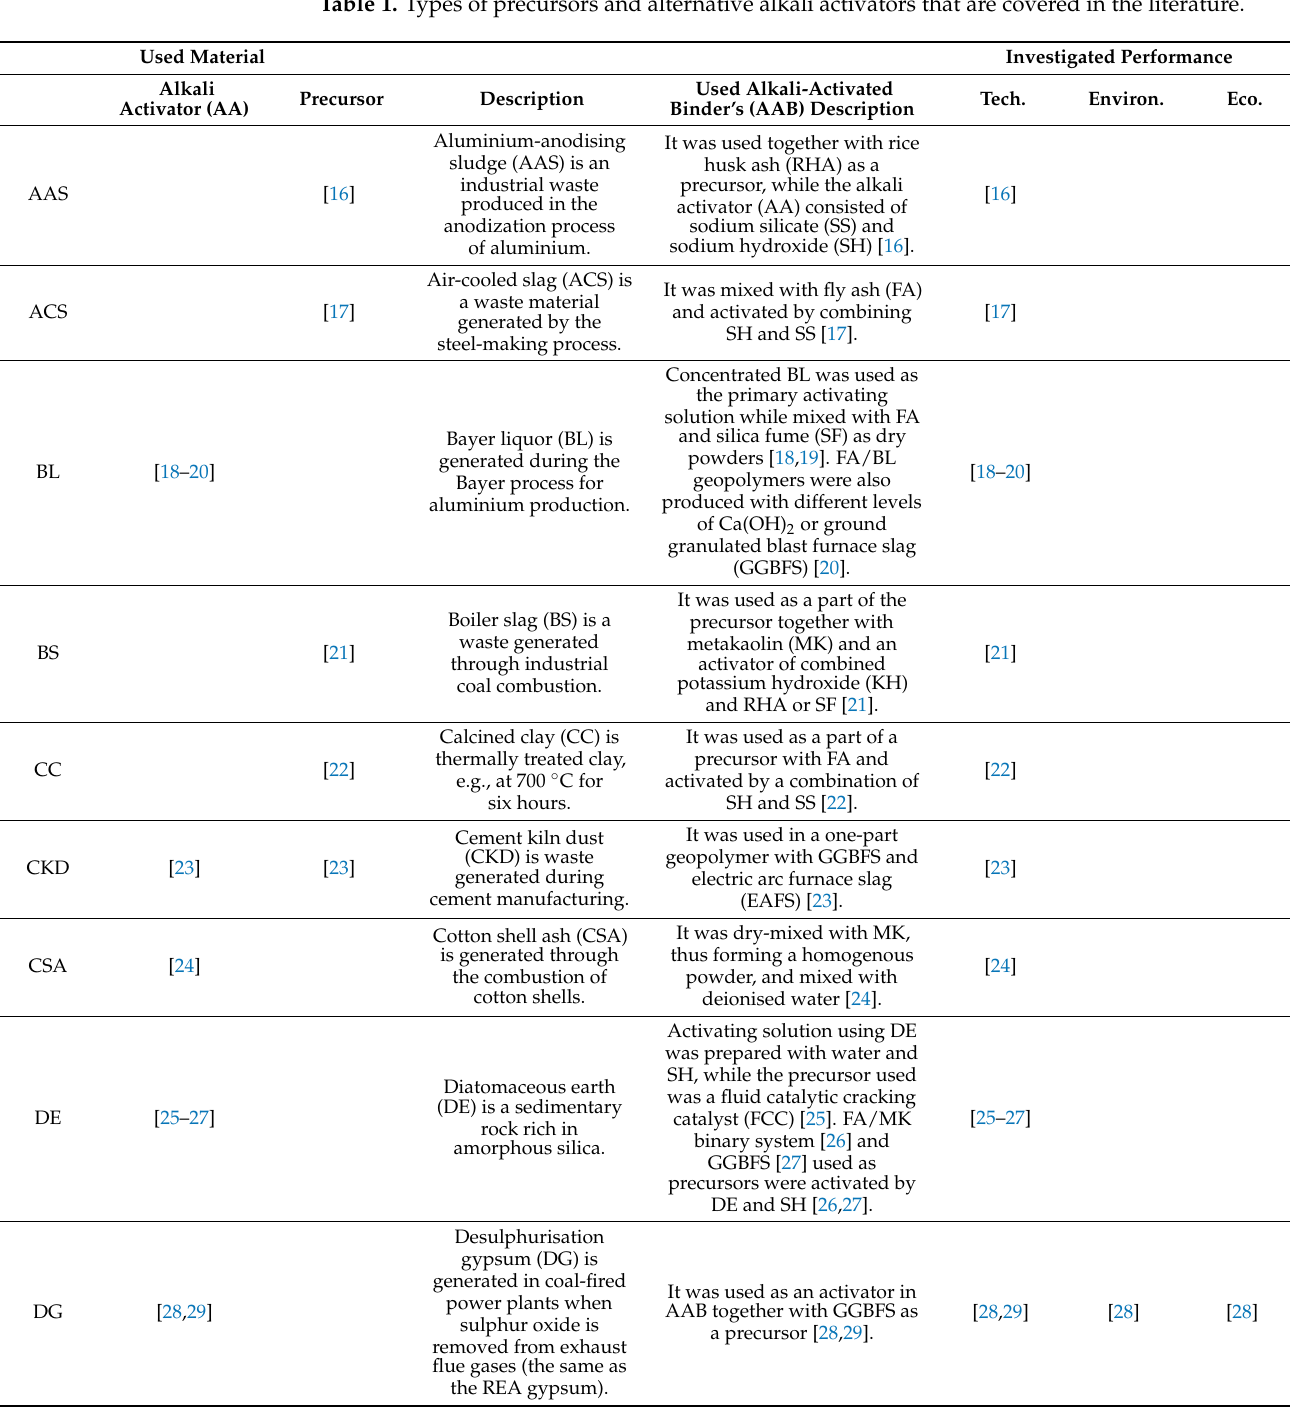
Table 1. Types of precursors and alternative alkali activators that are covered in the